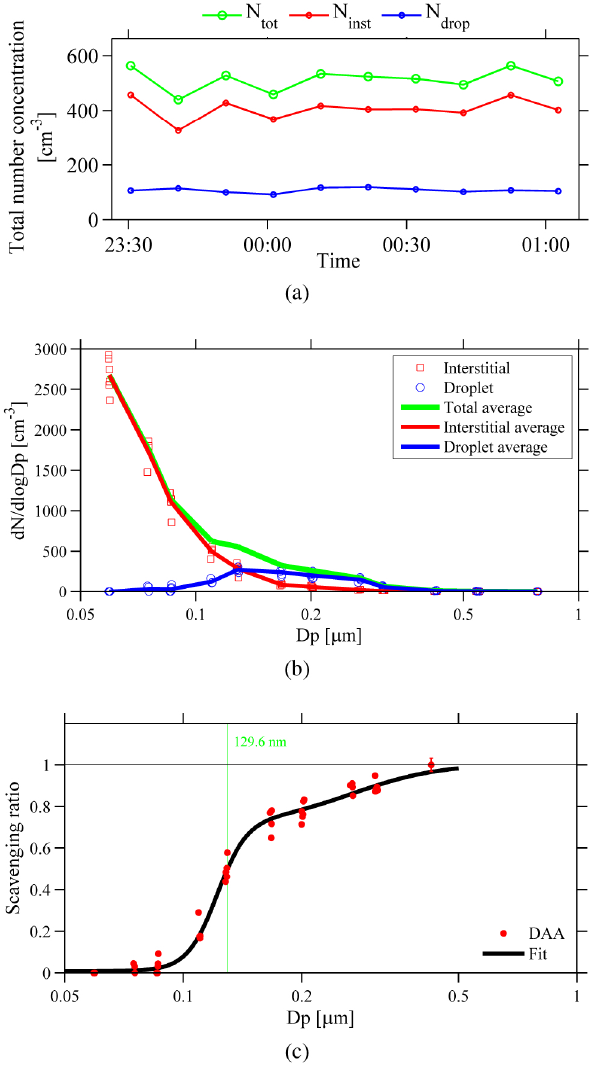
Fig. 4. (a) The total, interstitial and droplet number concentrations during the event, in the size range 49 to 563nm. (b) Dry (resid- ual) particle size distribution, d N/ dlog D p , of interstitial particles and droplets including averages (lines). (c) DAA scavenging ratio during the cloud event (red dots) with error bars indicating the esti- mated standard deviation in DAA counts during the event (smaller than the marker size for almost all data points), and a log-normal double-sigmoid fit (black line). The diameter for 50% activation is 0.13µm, indicated by the green